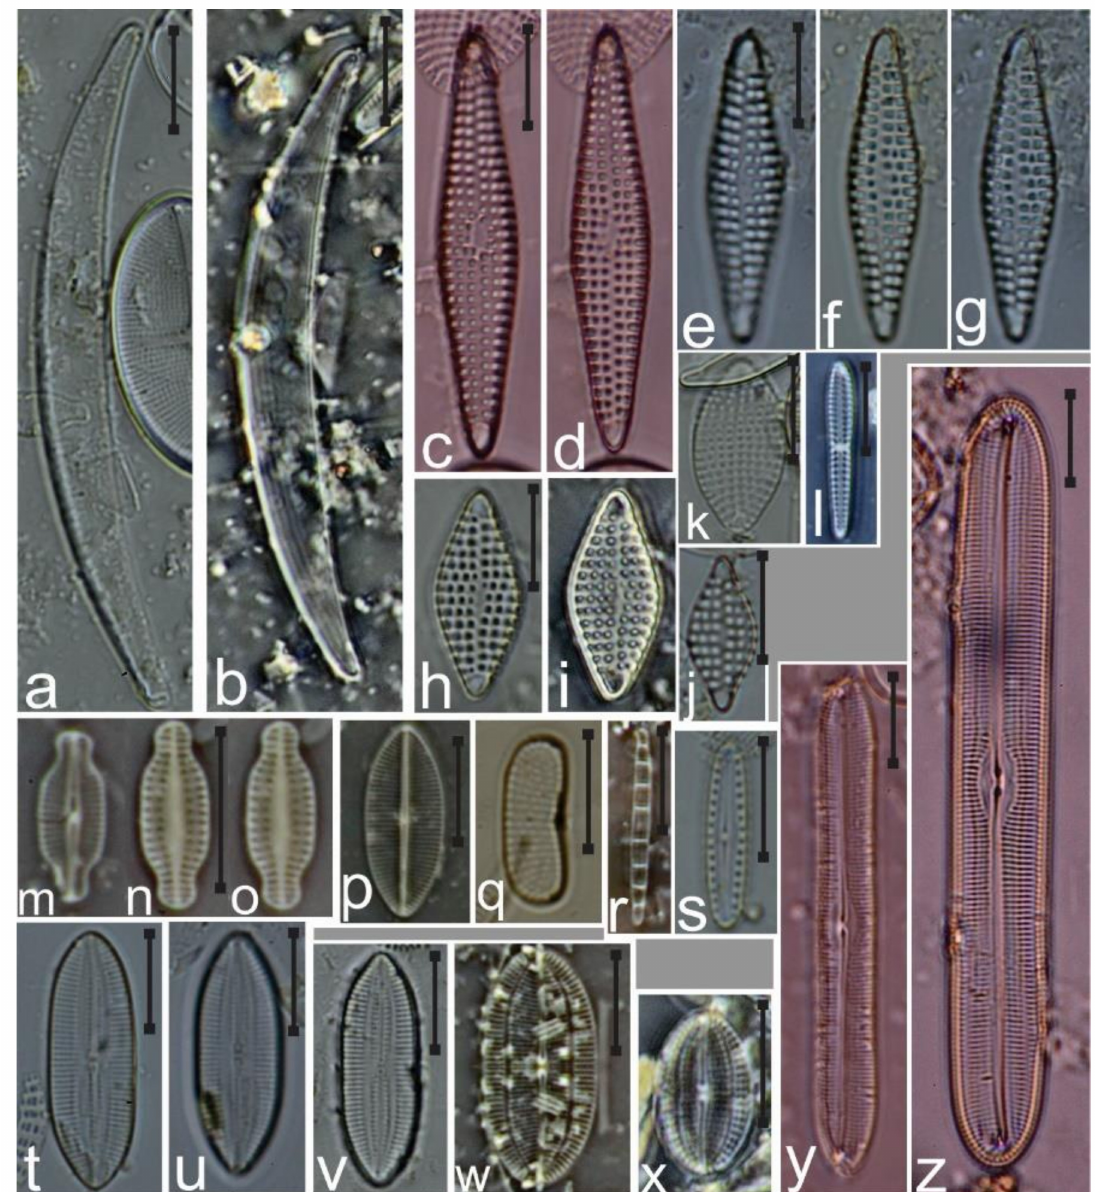
Figure 17. ( a , b ) Falcula media ; ( c , d ) Dimeregramma fulvum ; ( e – j ) D. minor ; ( k ) Delphineis minutissima ; ( l ) Gomphoseptatum aestuarii ; ( m – o ) Karayevia amoena , image m raphe valve, images n and o rapheless valve; ( p ) Astartiella bahusiensis ; ( q ) Colliculoamphora reichardtiana ; ( r ) Nagumoea vallus ; ( s ) Biremis lucens ; ( t – v ) Fallacia litoricola ; ( w , x ) F. vittata ; ( y ) Caloneis linearis ; ( z ) C. elongata . Scale bar = 10 µ